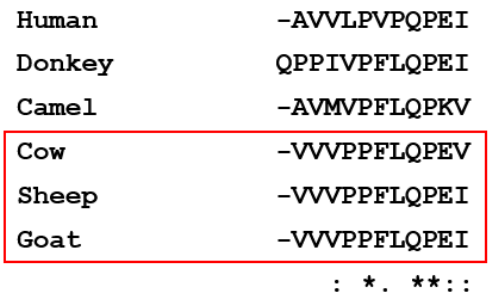
Figure 2. Sequence alignment of β -casein region VVVPPFLQPEV from the bovine, donkey, human, goat, and sheep milk. Sequences were obtained through the CLUSTAL multiple sequence alignment by MUSCLE (3.8) at https://www.ebi.ac.uk/Tools/services/web_muscle/toolform.ebi. (accessed on 2 December 2021). The asterisk (*) indicates the amino acids that are conserved between sequences. Finally, the LPLPLLQSWM region of the cow milk β -casein with high intensity of IgG binding was found to be very close to all of the considered